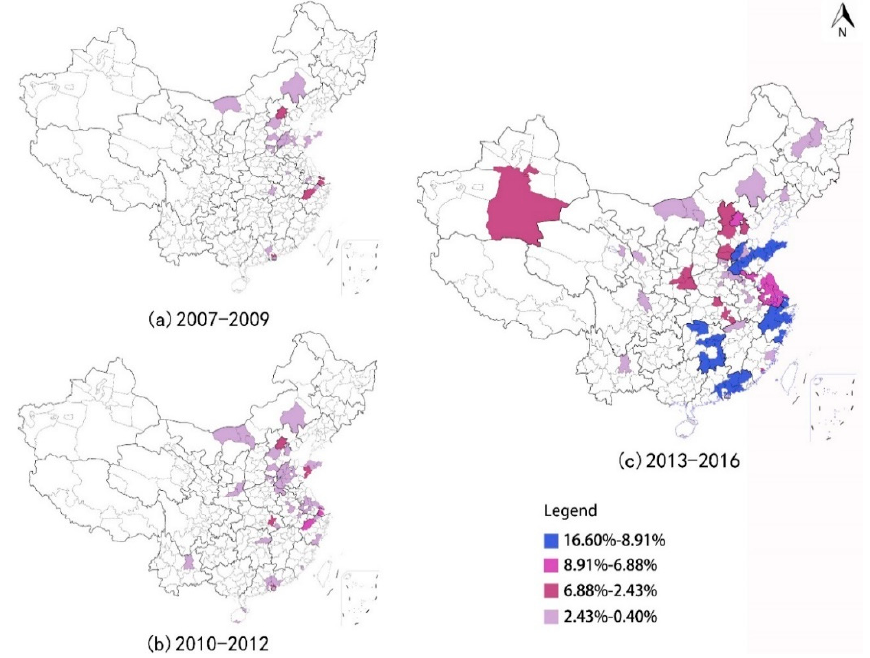
Figure 2. The dynamic change of photovoltaic applications across China’s urban areas.